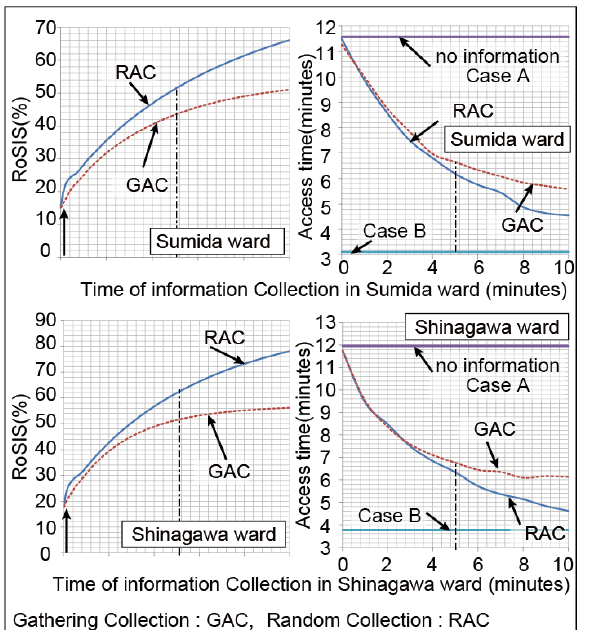
Figure 13. Relationship between the number of volunteers and access time of firefighters and